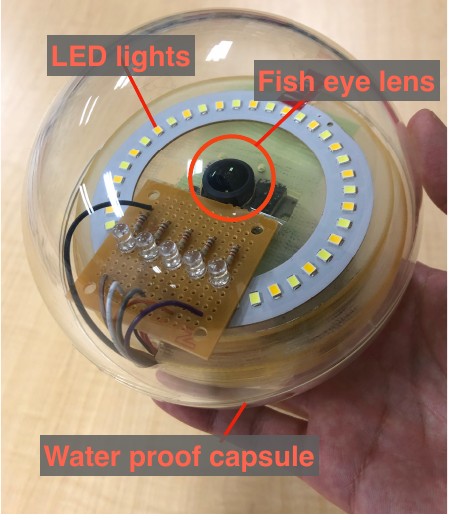
Figure 2. CN prototype with a waterproof